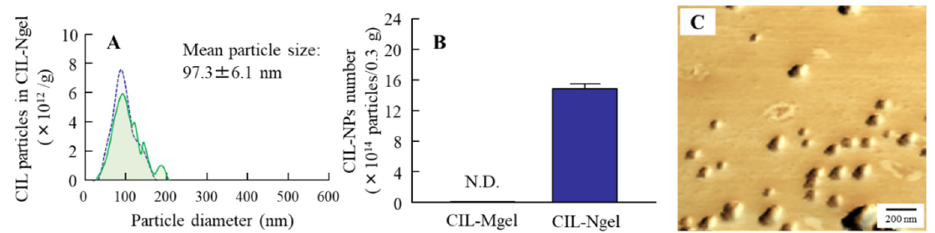
Figure 3. The stability of CIL particles in the CIL-Ngel. ( A ) Changes in size frequency in the CIL-Ngel immediately (blue)